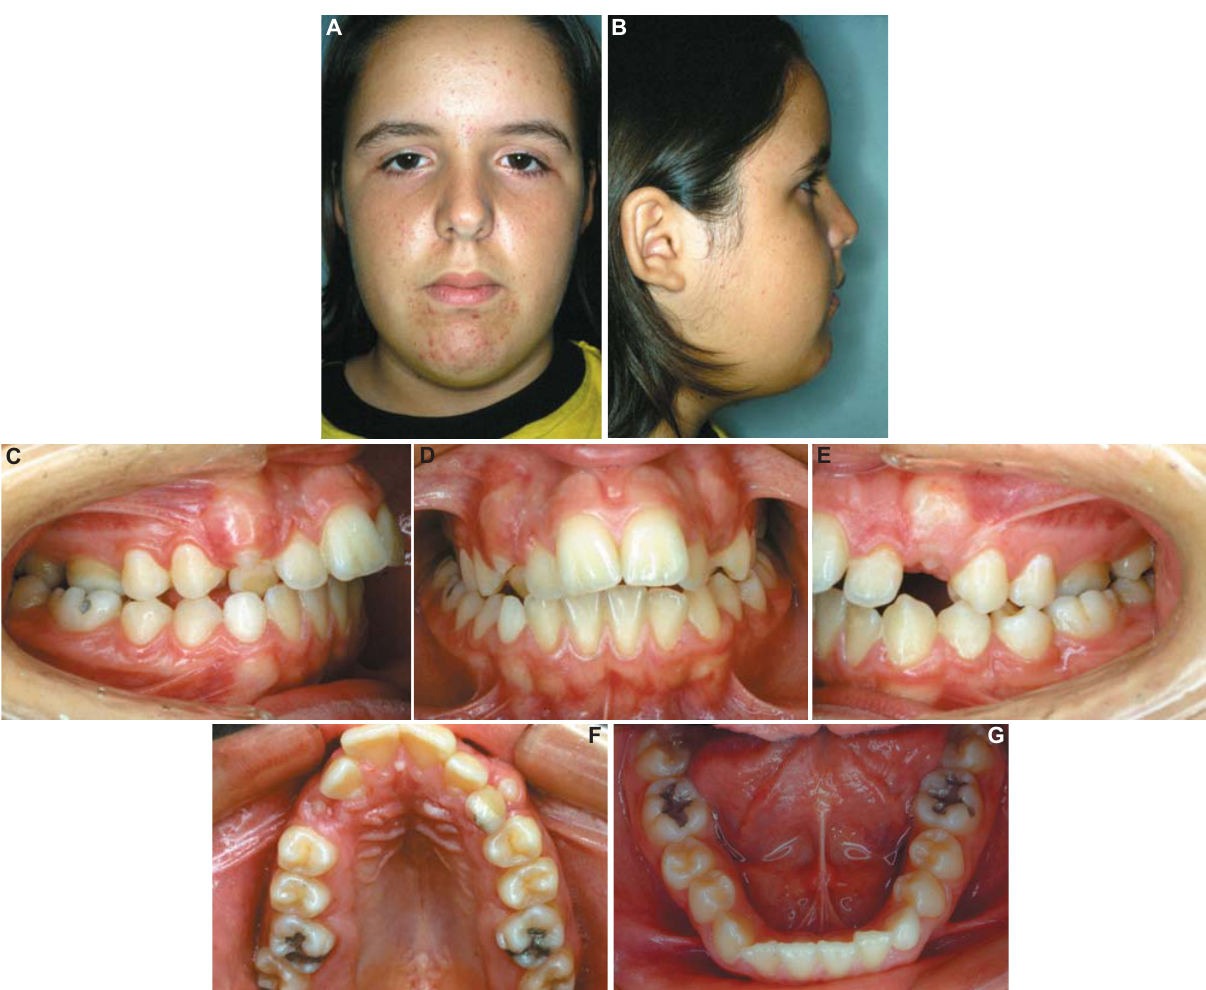
Figure 1- Pretreatment extraoral (A and B) and intraoral (C-G) photographs (parents authorized the publication of these pictures)